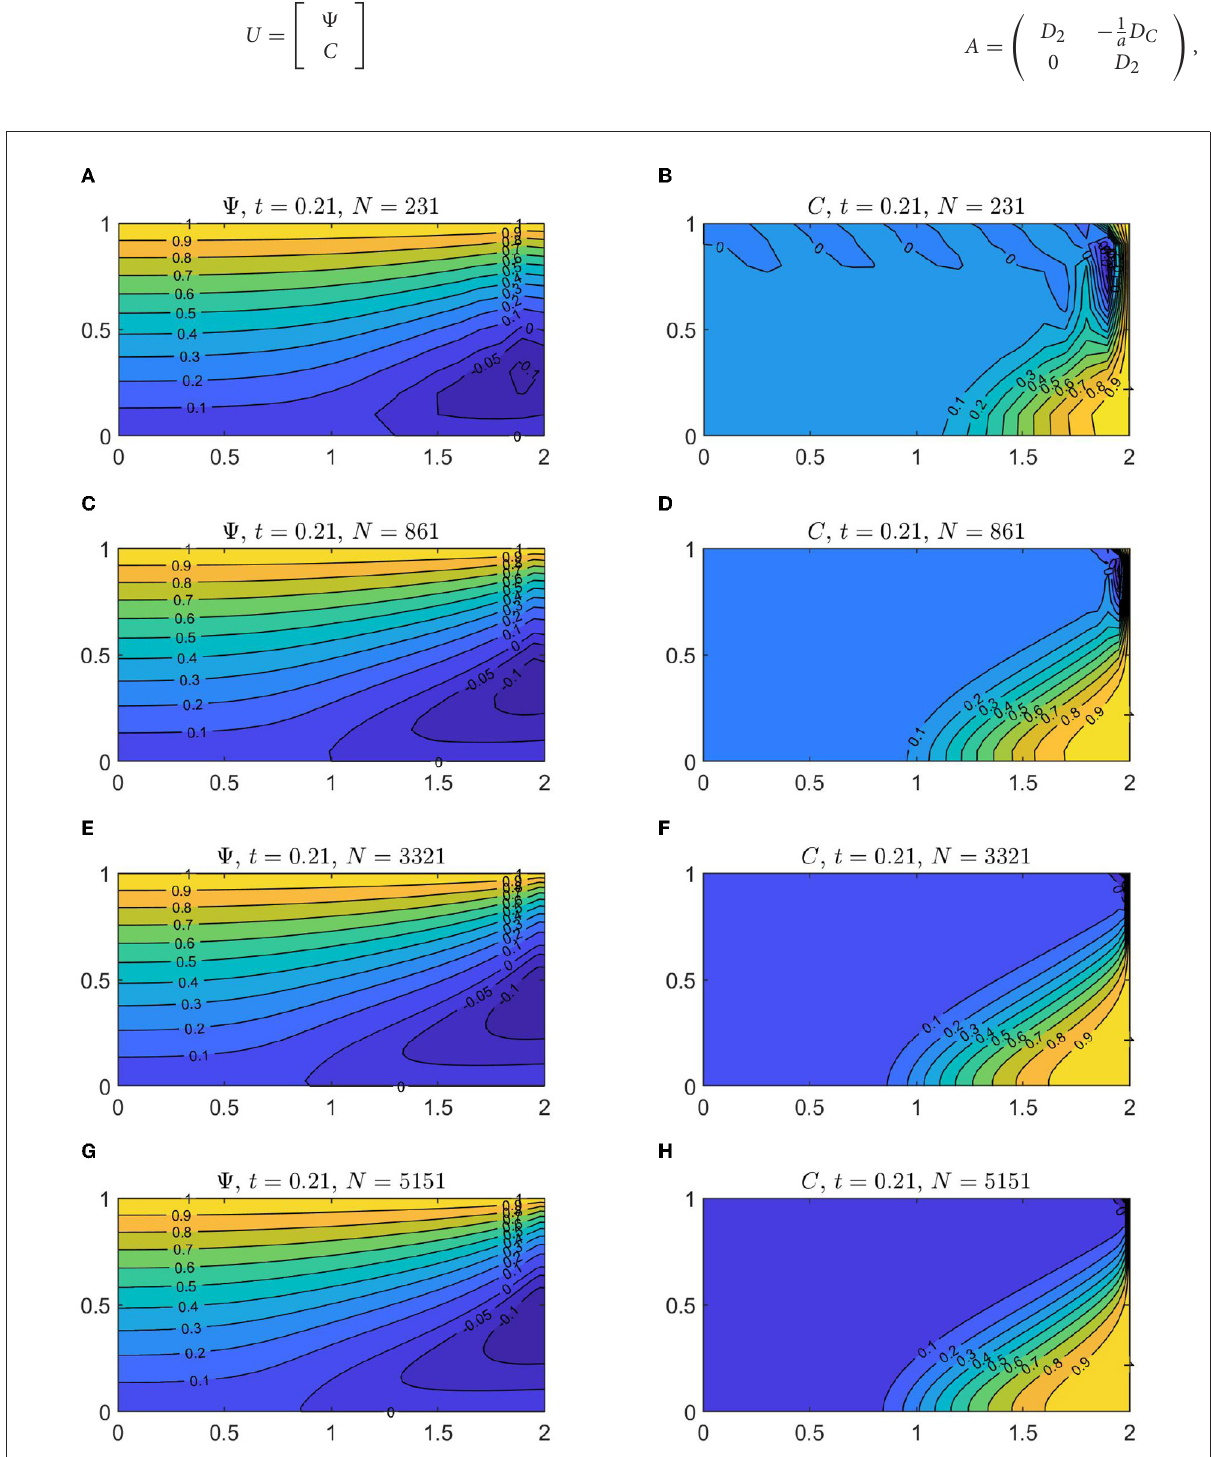
FIGURE10 Steady-state streamline distributions (Left) and steady-state concentration distributions (Right), for Pinder version of Henry problem ( a = 0.2637, b = 0.035) using different number of total nodes. (A,B) N = 21 × 11 = 231, (C,D) N = 41 × 21 = 861, (E,F) N = 81 × 41 = 3,321, (G,H) N = 101 × 51 =